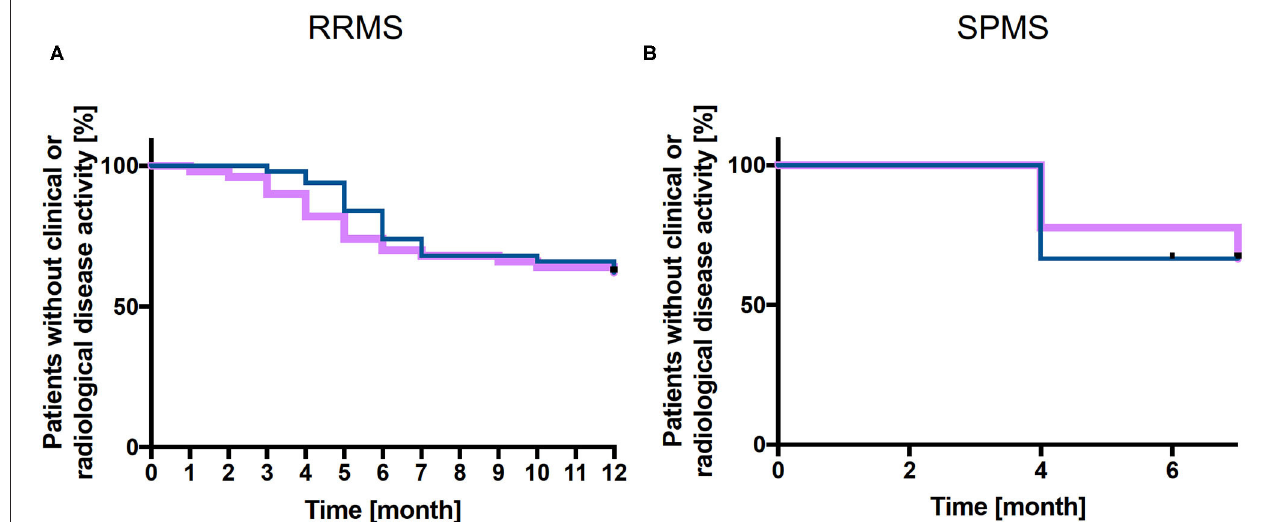
FIGURE 1 | Kaplan-Meier analysis of relapse-free survival and without new and/or enlarging T2 lesions. Relapse free (purple line) and without new/enlarging T2 lesions survival (blue line) is presented for cohort 1 (RRMS patients, n = 50) up to 12 months (A) and for cohort 2 (SPMS patients, n = 9) up to 7 months (B) after NAT